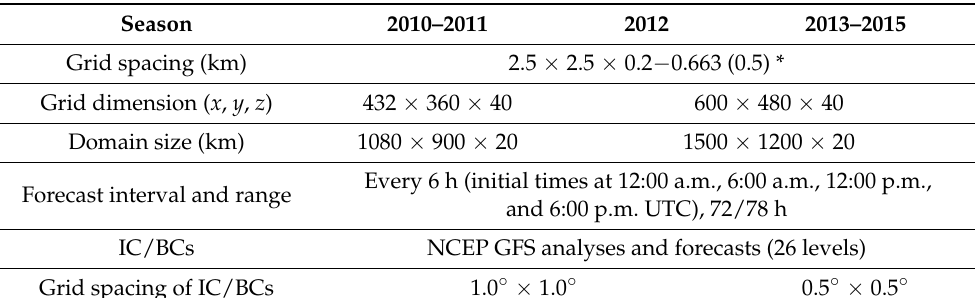
Table 1. The basic domain and configuration of the 2.5 km CReSS in